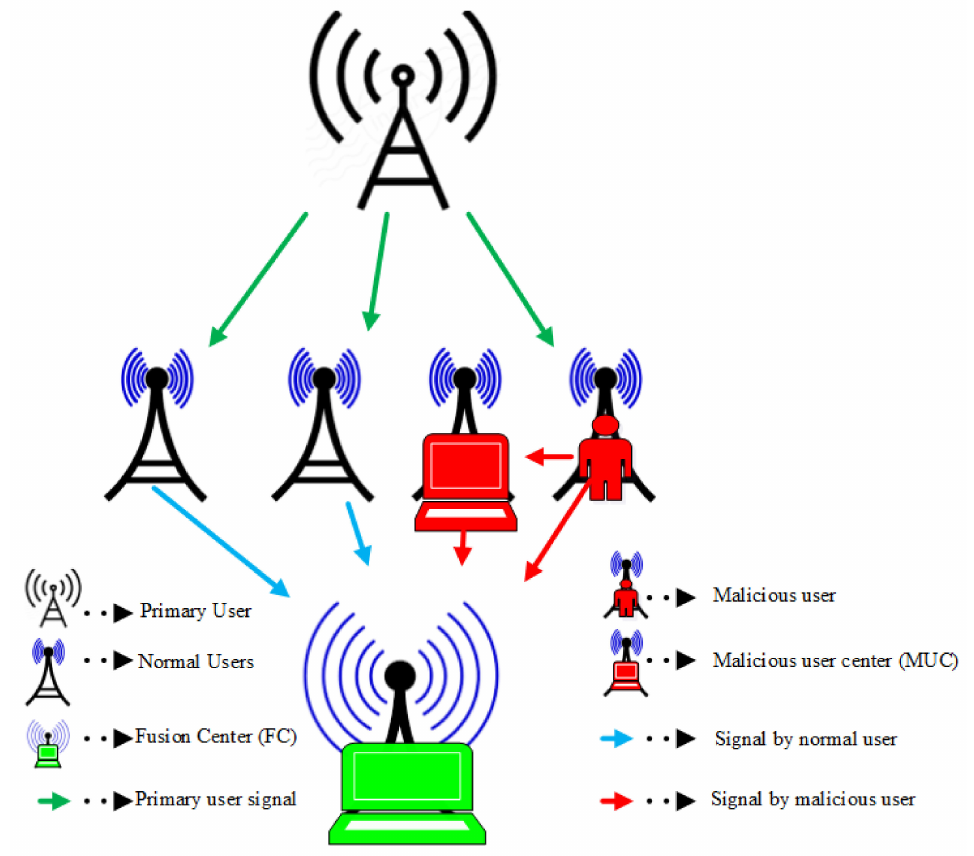
Figure 1. Conventional centralized cooperative spectrum sensing